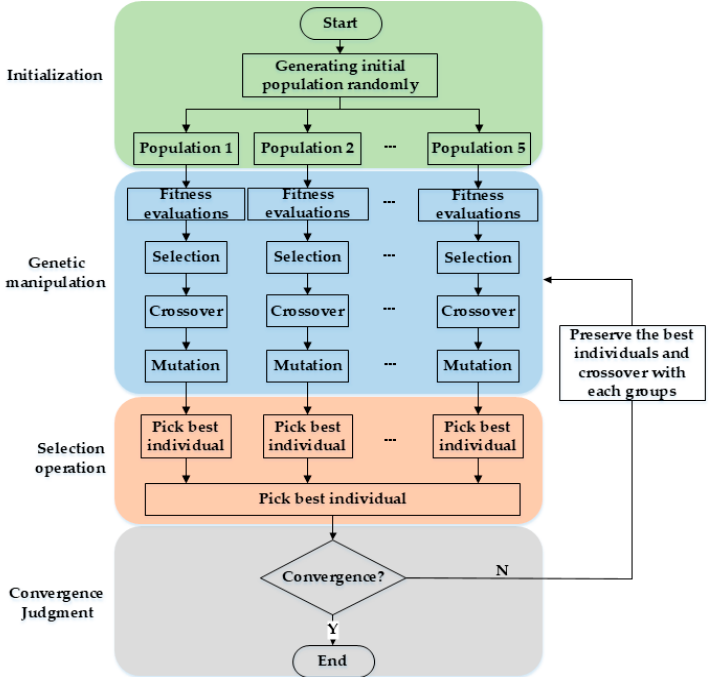
Figure 1. Flow chart of improved multi-population genetic algorithm (IMPGA).